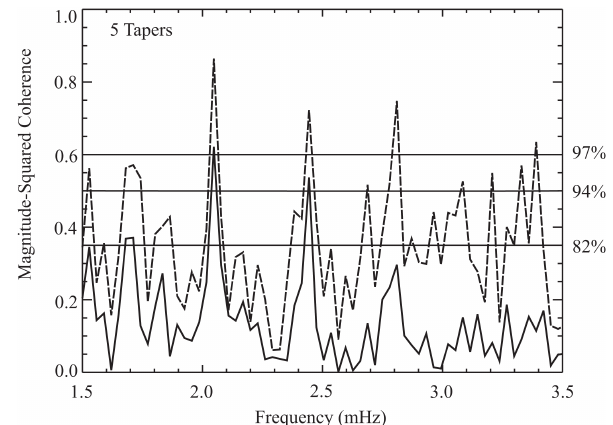
Figure 1. Magnitude-squared coherence (full line) between ACE V x and Sanae Doppler velocity in beam 4 at AACGM lat- itude − 66.4 ◦ S for the period from 09:50 to 19:00UT on 7 June 2000. The horizontal lines show the cumulative distribu- tion function estimates of the confidence level. The dashed line is drawn one standard deviation above the coherence curve. From Stephenson and Walker